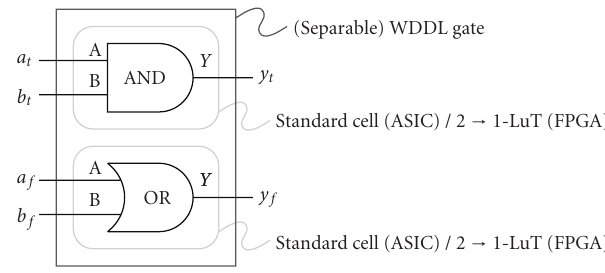
Figure 1: WDDL AND gate, suitable for both ASICs and